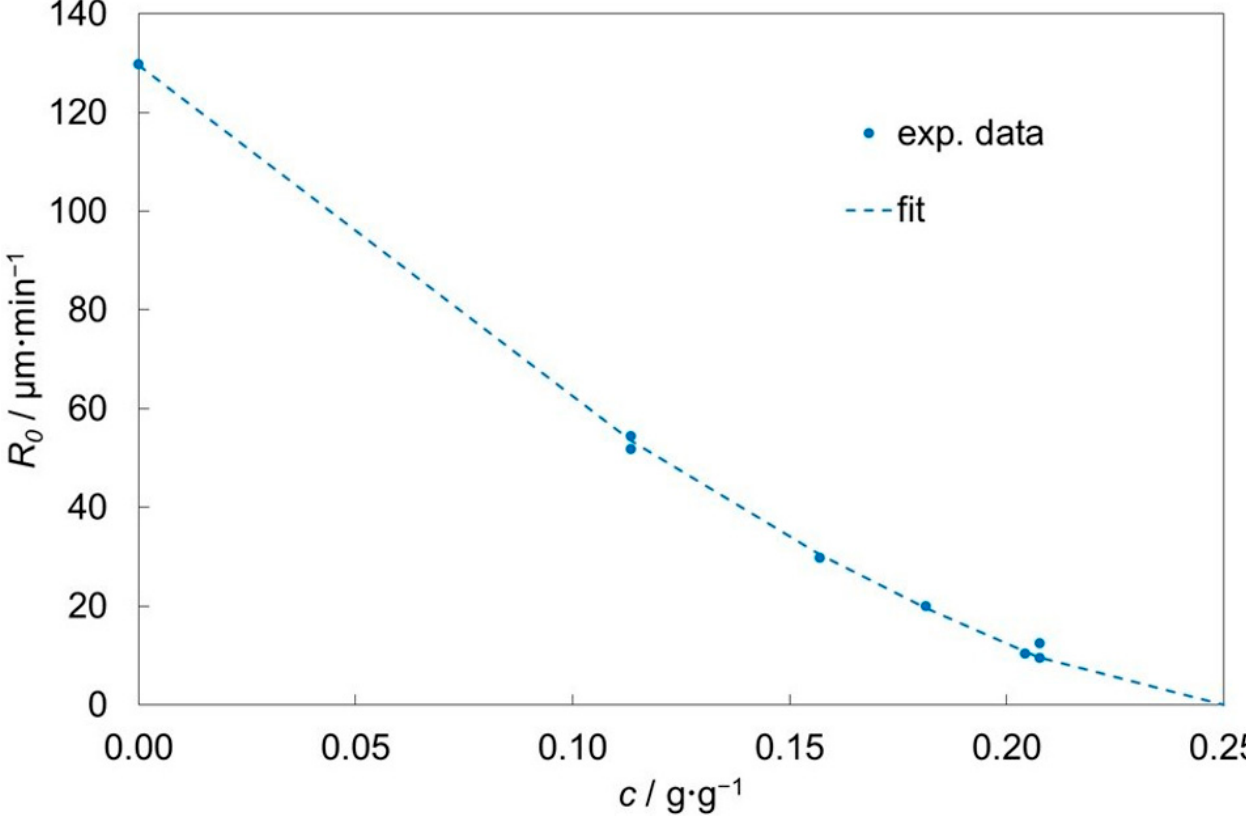
Figure 7. Face displacement velocities of the (110) glycine facet in stagnant aqueous glycine solutions.